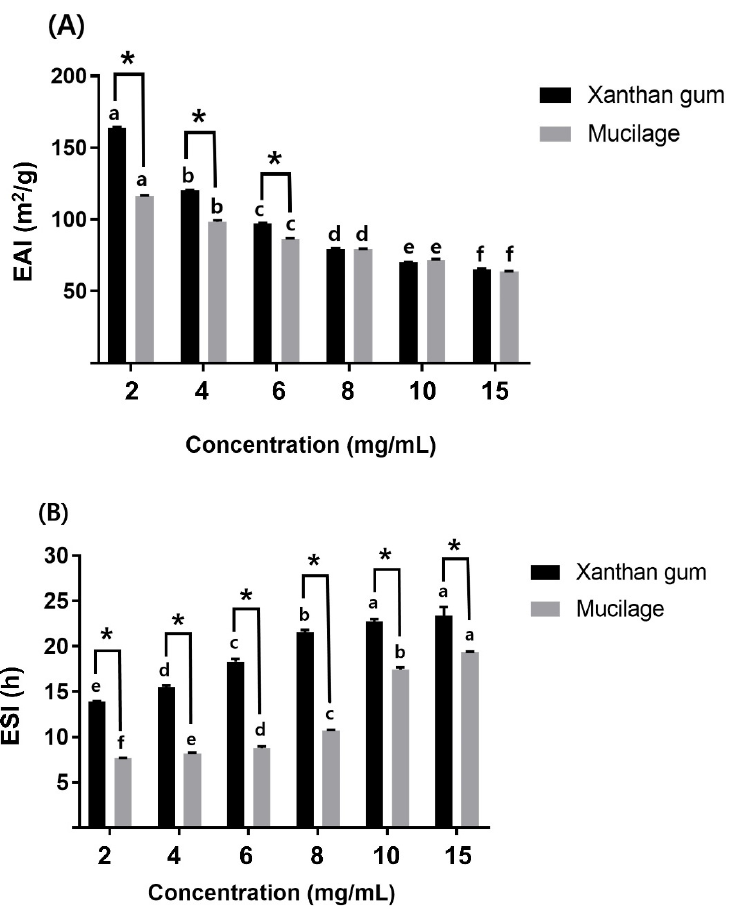
Figure 5. ( A ) Emulsifying activity index and ( B ) emulsifying stability index. Bars showing different labels (a–f) are significantly different ( p < 0.05) in each sample at different concentrations. Bars labeled with an asterisk (*) are significantly different ( p < 0.05) between the mucilage solution and xanthan gum solution at the same concentration.